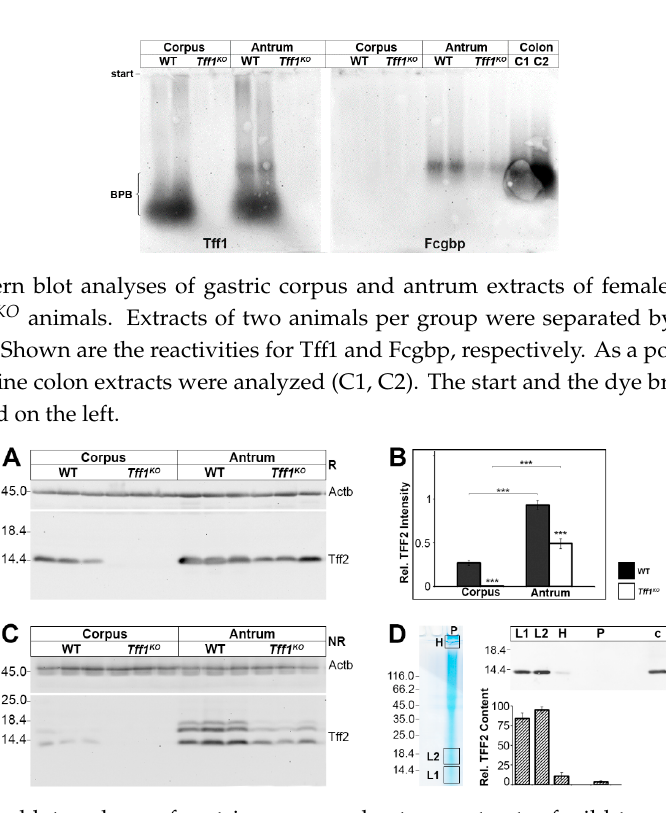
Figure 4. Western blot analyses of gastric corpus and antrum extracts of wild-type (WT) and T ff 1 KO animals. ( A ) Extracts of three male animals per group were separated on a 15% SDS-PAGE under reducing conditions and analyzed for their Tff2 reactivity. Left: molecular mass standard. Loading control: reactivity for ß-actin (Actb). ( B ) Semi-quantitative analysis of the relative Tff2 content (10 male animals per group). Significances are indicated by asterisks (***, p ≤ 0.001). WT animals: black bars; Tff1 KO animals: white bars. ( C ) Analysis of the same samples as in (A), but under non-reducing conditions (post-in-gel reduction). ( D ) Left: Non-reducing SDS-PAGE (Coomassie-stained) of an antral extract of a single male WT animal (75 µ g) followed by elution of the high-(H) and low-molecular mass regions (L1, L2). Additionally, the remaining high-molecular-mass samples not entering the gel were removed from the gel pockets (P). Right: Western blot analysis (reducing conditions) concerning T ff 2 of L1, L2, H, P, and an antral extract as a control (c) and semi-quantitative analysis of the relative T ff 2 content (six male WT animals; 60–75 µ g /